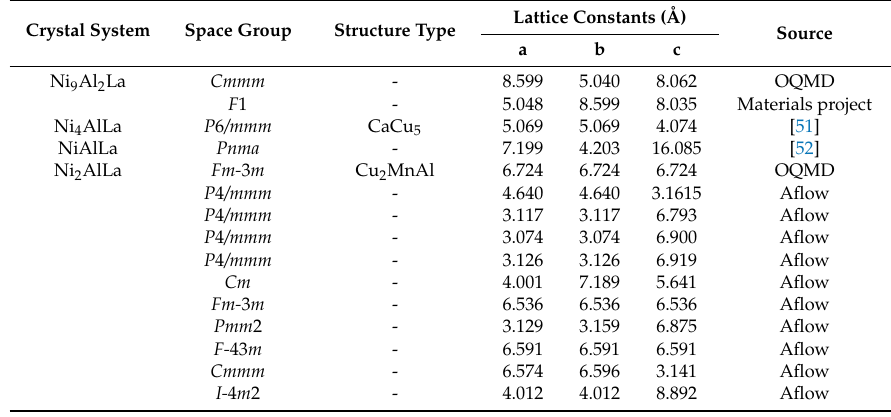
Table 1. Crystal structure of ternary compound in nickel-rich corner of Ni – Al – La ternary system from different sources.